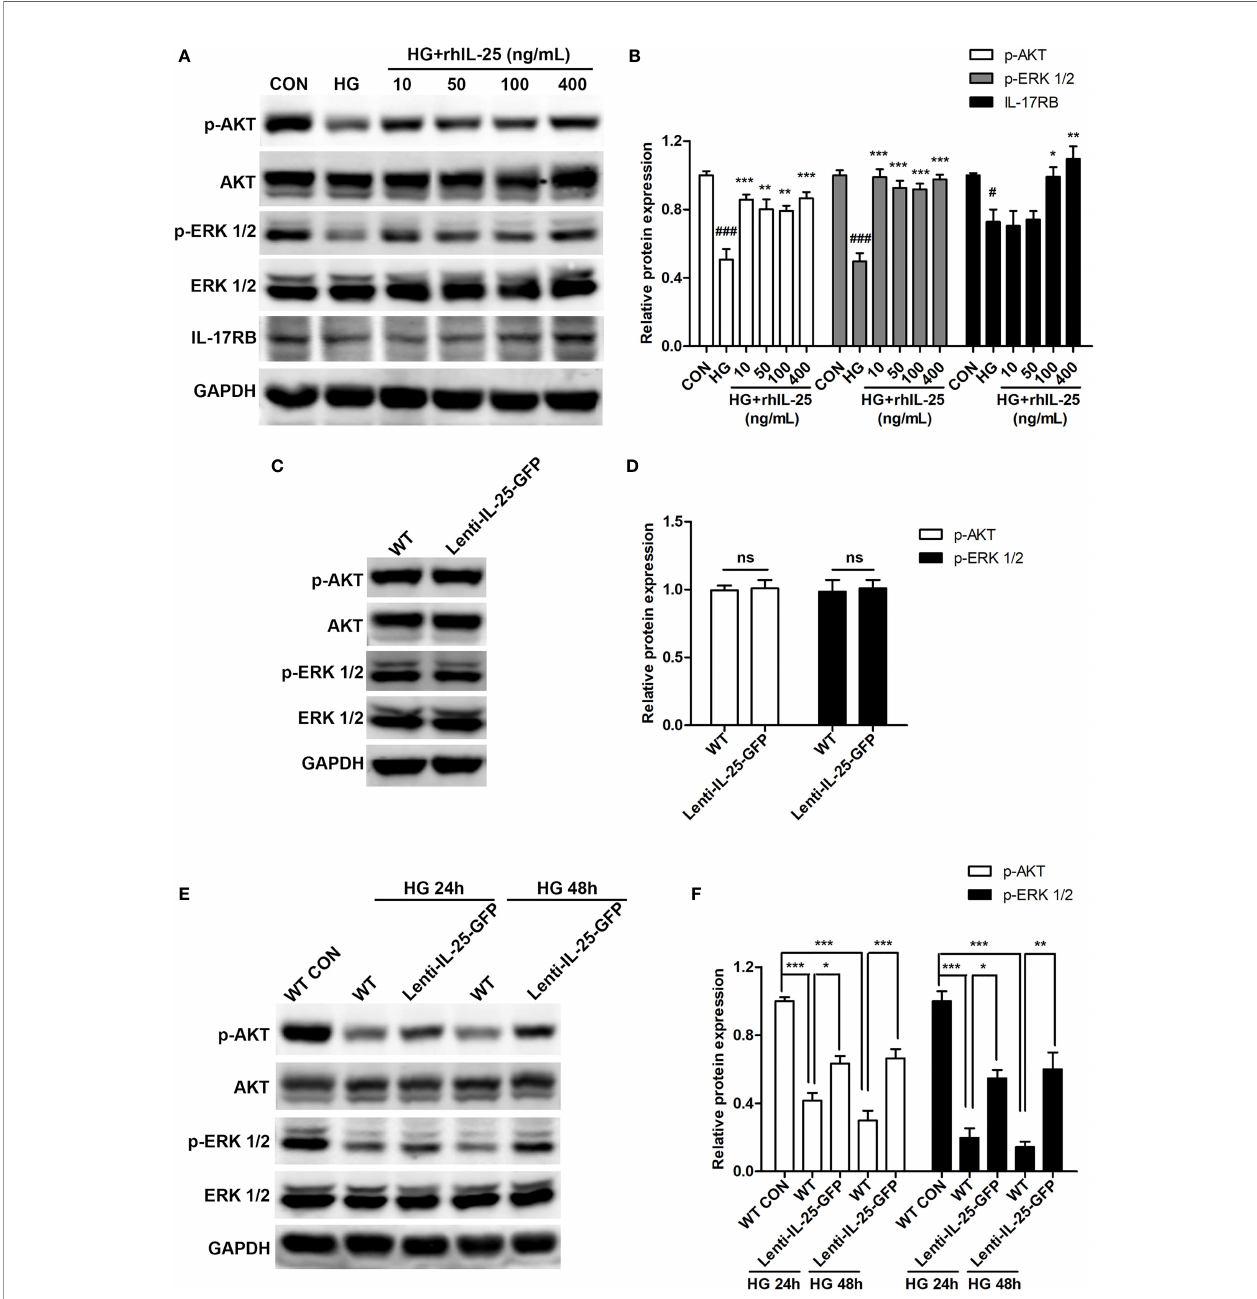
FIGURE 8 | IL-25 induces AKT and ERK 1/2 phosphorylation in HUVECs under high glucose conditions. (A, B) HUVECs were cultured in 6-well plate. After grown to 80%, cells were treated with high glucose medium in the presence of a gradient of rhIL-25. Proteins were collected for western blotting analysis after culturing for another 48 h. Representative western blotting images of p-AKT, p-ERK 1/2 and IL-17RB (A) and their quanti fi cation (B) (n = 3) were shown. (C, D) WT-HUVECs and Lenti-IL-25-GFP-HUVECs were cultured in normal glucose conditions and proteins were collected for western blotting analysis. Representative western blotting images of p-AKT and p-ERK 1/2 (C) and their quanti fi cation is displayed in the graph (D) (n = 3). (E, F) WT-HUVECs and Lenti-IL-25-GFP-HUVECs were treated with high glucose for 24 or 48 h and the proteins were obtained for western blotting analysis. Representative western blotting images (E) and quanti fi cation (F) of p-AKT and p-ERK 1/2 (n = 3) were shown. * and # P < 0.05, ** P < 0.01, *** and ### P < 0.001 ( # compared with CON group, *compared with HG group). ns, no signi fi